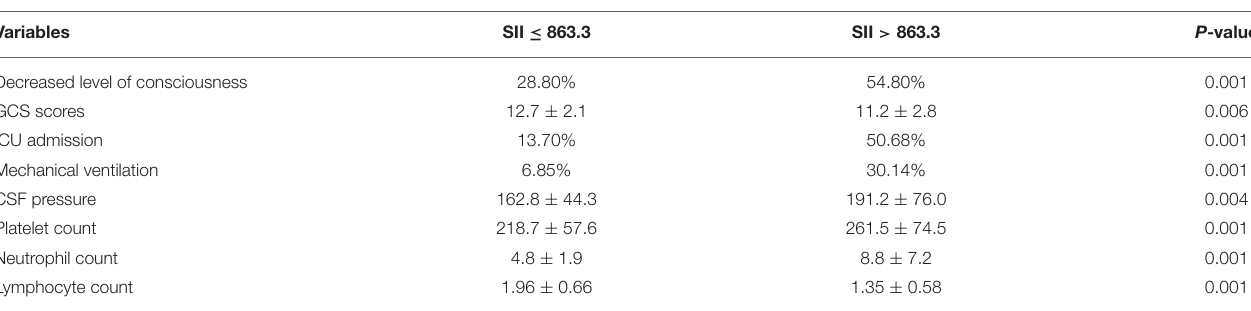
TABLE 4 | Relationship between SII and clinical indexes in patients with